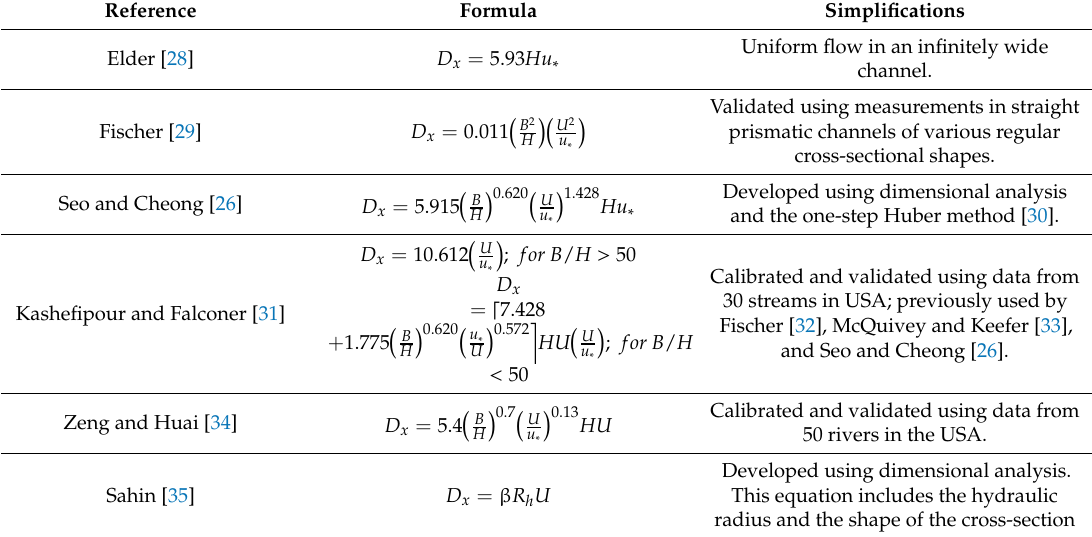
Table 1. One-dimensional longitudinal dispersion formula-associated